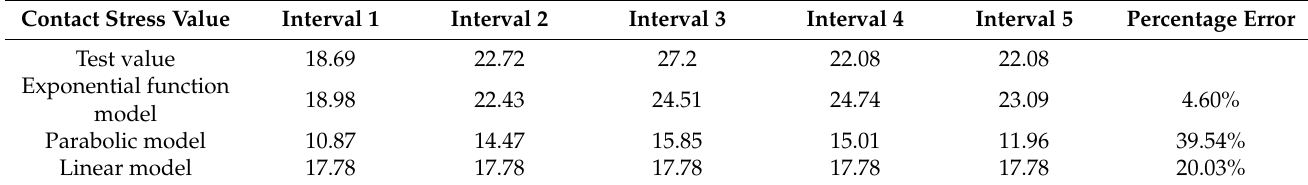
Table 5. Error comparison between different models and experimental stress values (N/cm 2 ) ( λ = 7.5).